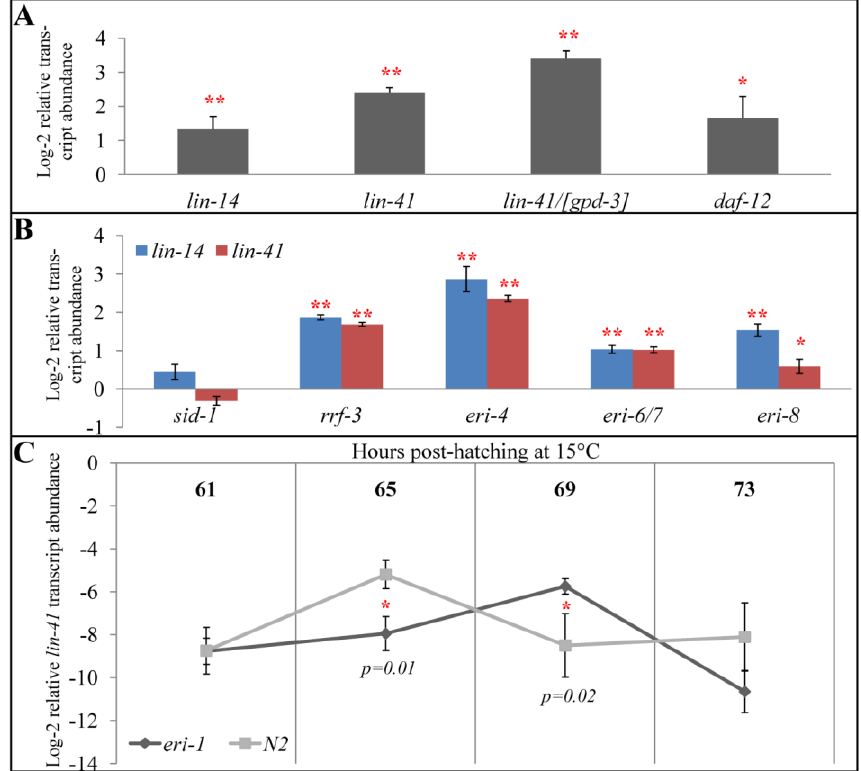
Figure 2. Expression of let-7 -regulated transcripts in endo-RNAi mutant